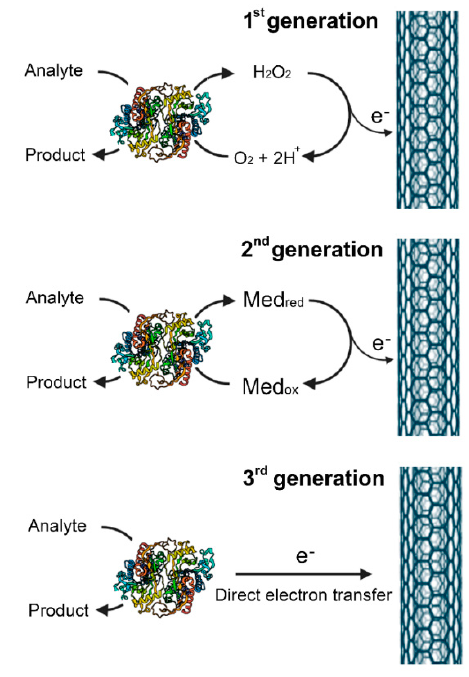
Figure 1. Different generations of amperometric biosensors. In the first biosensor generation, the decrease in oxygen concentration or the produced hydrogen peroxide are measured; in the second biosensor generation, specific mediators transfer the electrons to the electrode; in the third biosensor generation, the electrons are directly transferred from the enzyme to the electrode.